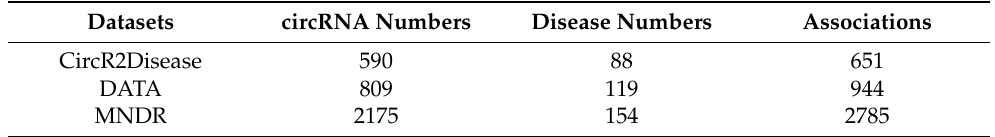
Table 1. The used